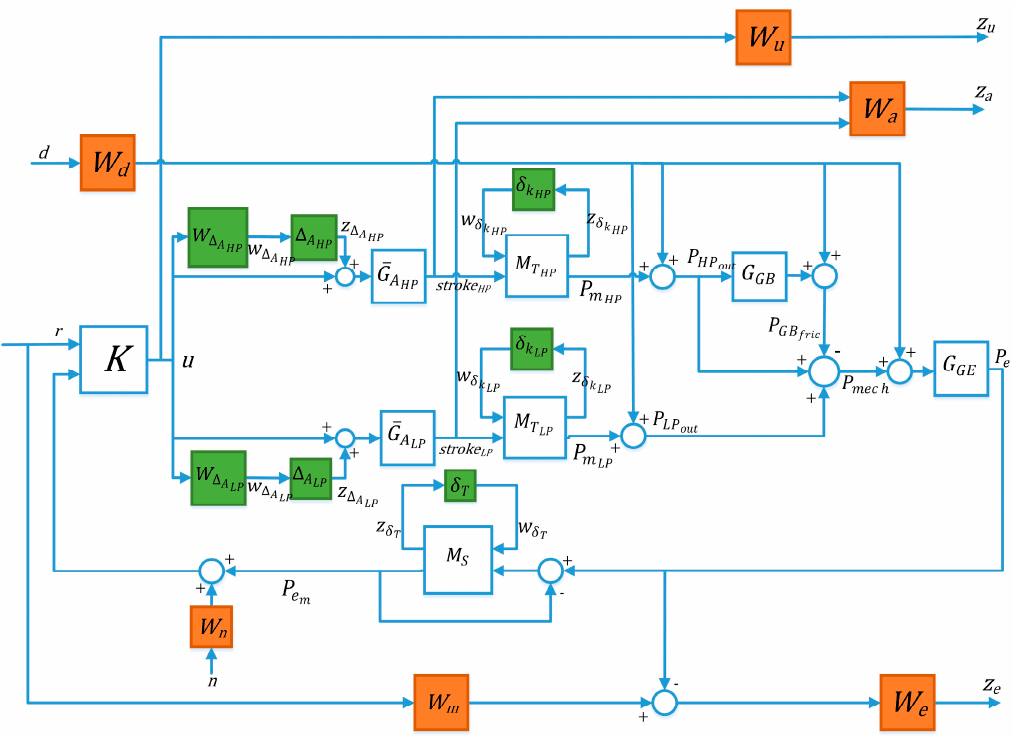
Figure 12. Block diagram of the closed-loop system with uncertainties and performance specifications.